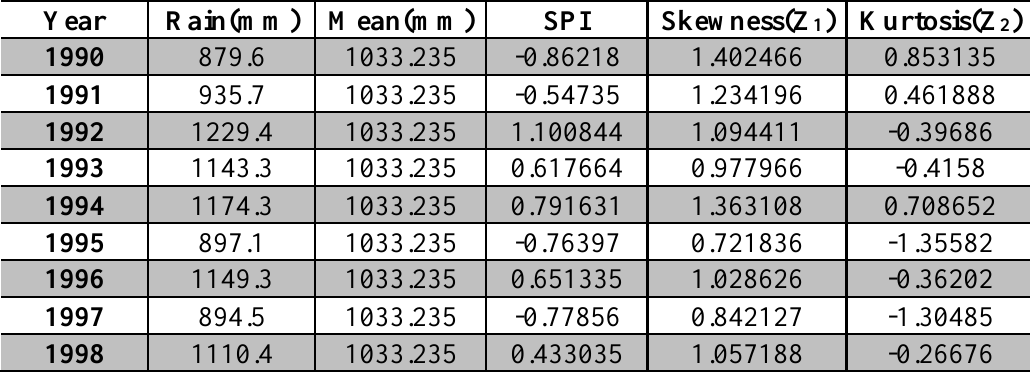
Table 2: Statistical Analysis of rainfall in Gombe metropolis from 1990 to